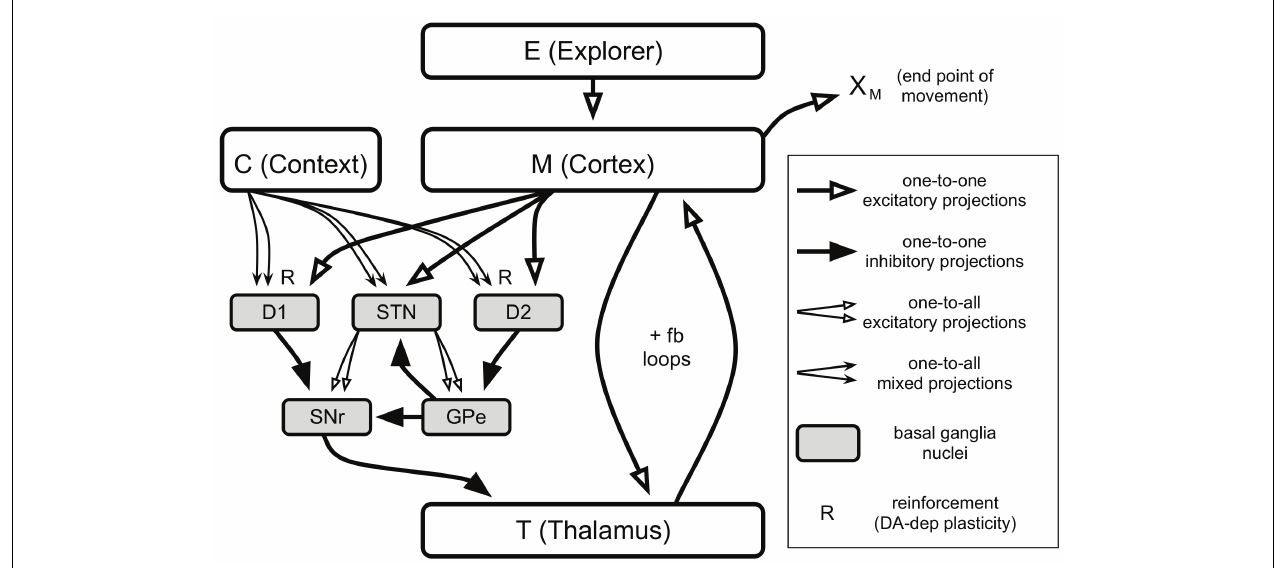
FIGURE 1 | Architecture of the model. Each box except for “C (Context)” contains 196 neurons spatially arranged in a 14 × 14 grid. Context contains just one neuron. Types of projections are labeled in the legend on the right.